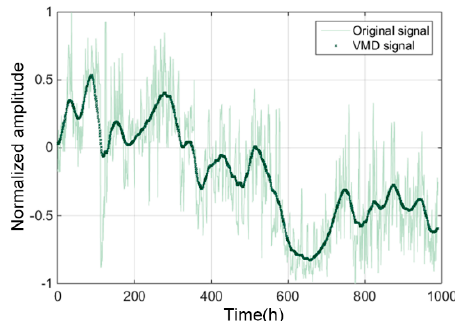
Figure 10. Effect of VMD in decomposing and extracting characteristics trends.